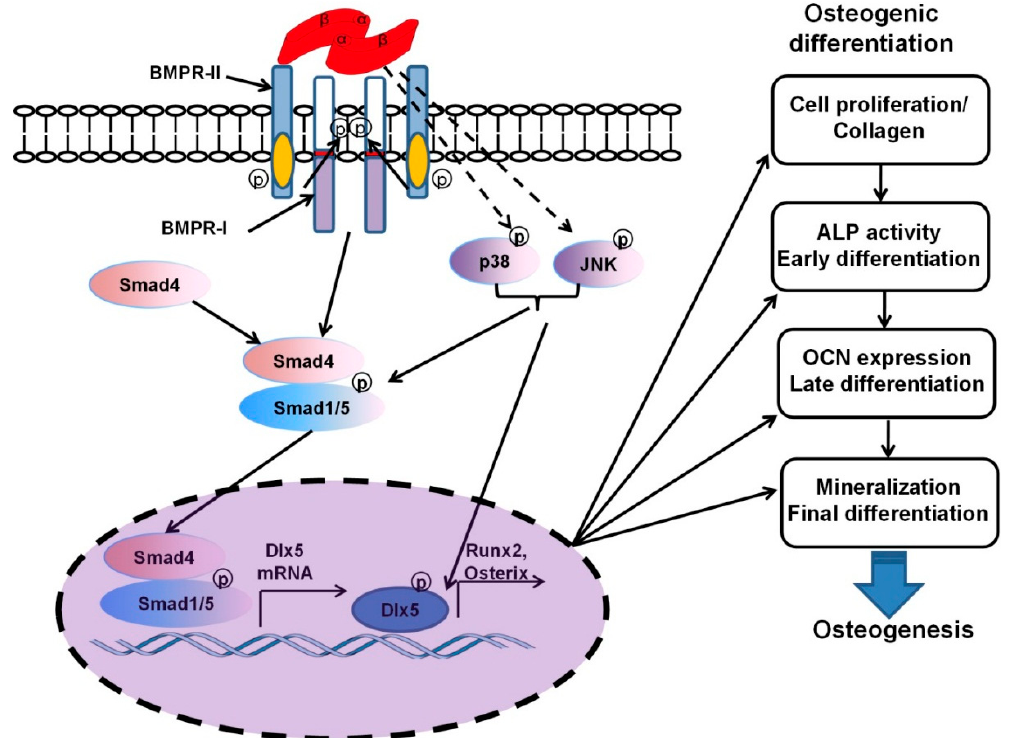
Figure 1. Schematic graphs depicting the signaling pathways of bone morphogenetic proteins (BMPs) and its-induced osteogenic activities. BMPR-I: BMP type I receptors; BMPR-II: BMP type II receptors; Runx2: runt-related transcription factor 2; ALP: alkaline phosphatase; OCN: osteocalcin; Dlx5: distal-less homeobox 5; JNK: c-Jun N-terminal kinase;